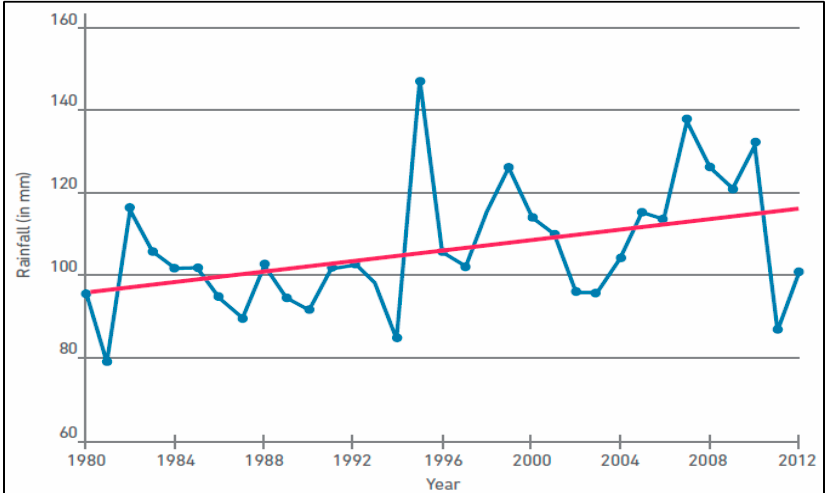
Figure 1. Annual maximum hourly rainfall intensities in Singapore based on records from 28 stations from 1980 to 2012 (blue line/dots), with trend towards higher rainfall intensities (pink line) [6].